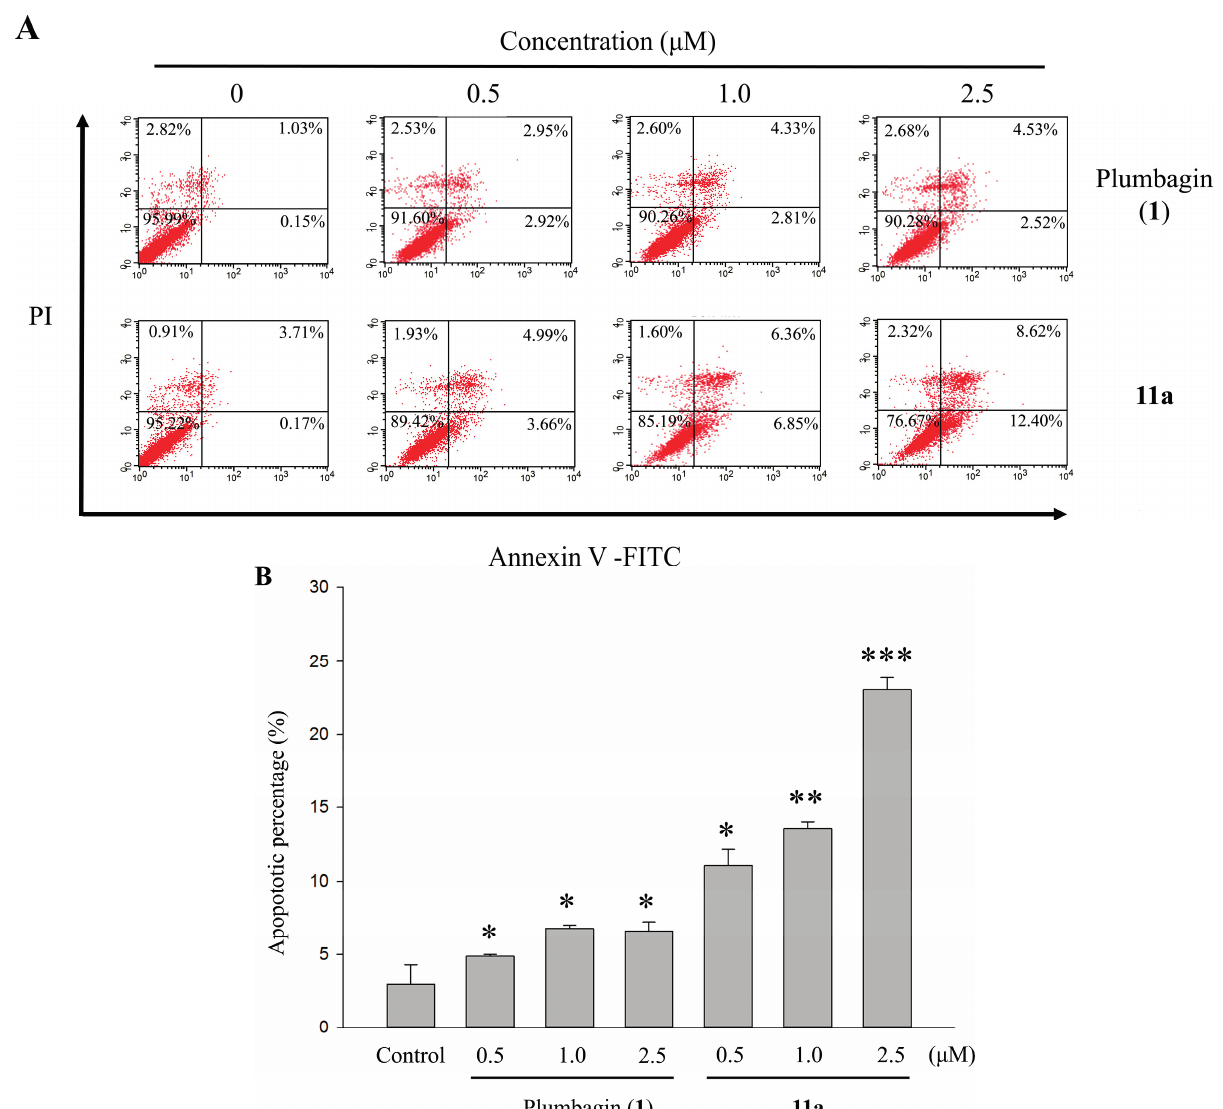
Figure 4. ( A ) The effects of the 48 h treatments with 0–2.5 μ M plumbagin ( 1 ) and 11a